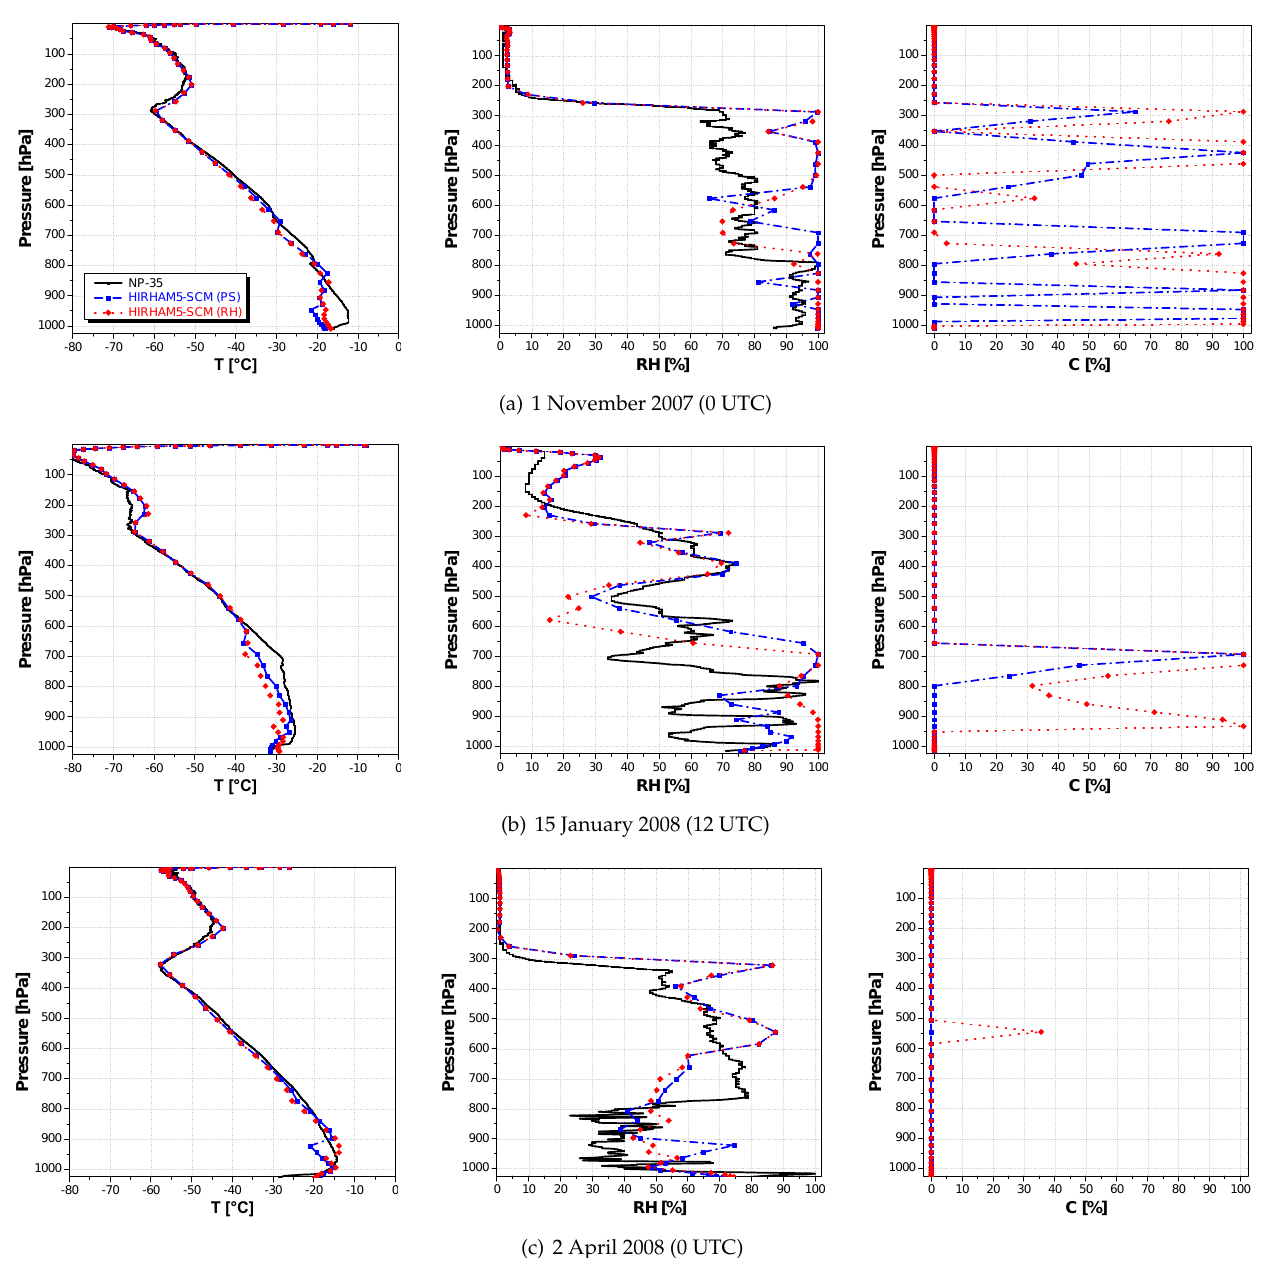
Figure 1. Vertical profiles of temperature T (in ◦ C ) ( left column ), relative humidity RH (in %) ( middle column ), and fractional cloud cover C (in %) ( right column ) at various dates, originating from NP-35 radiosonde ascents ( black curves ) and HIRHAM5-SCM simulations using either the PS-Scheme ( blue curves ) or RH-Scheme ( red curves ).